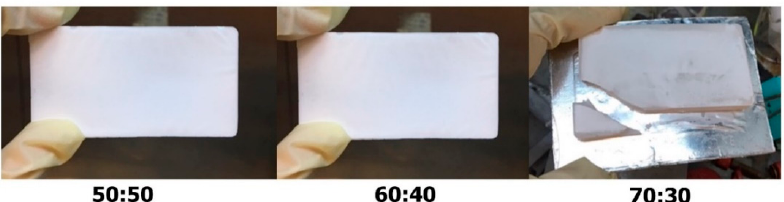
Figure 3. Physical observation of solid monoliths produced using different ratios of templates and monomers (50:50, 60:40, 70:30).